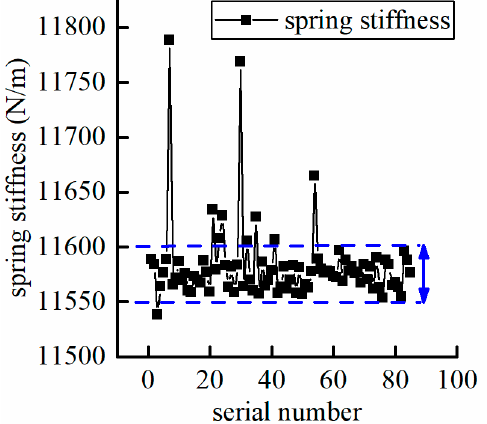
Figure 13. Pareto optimal solutions of spring stiffness.